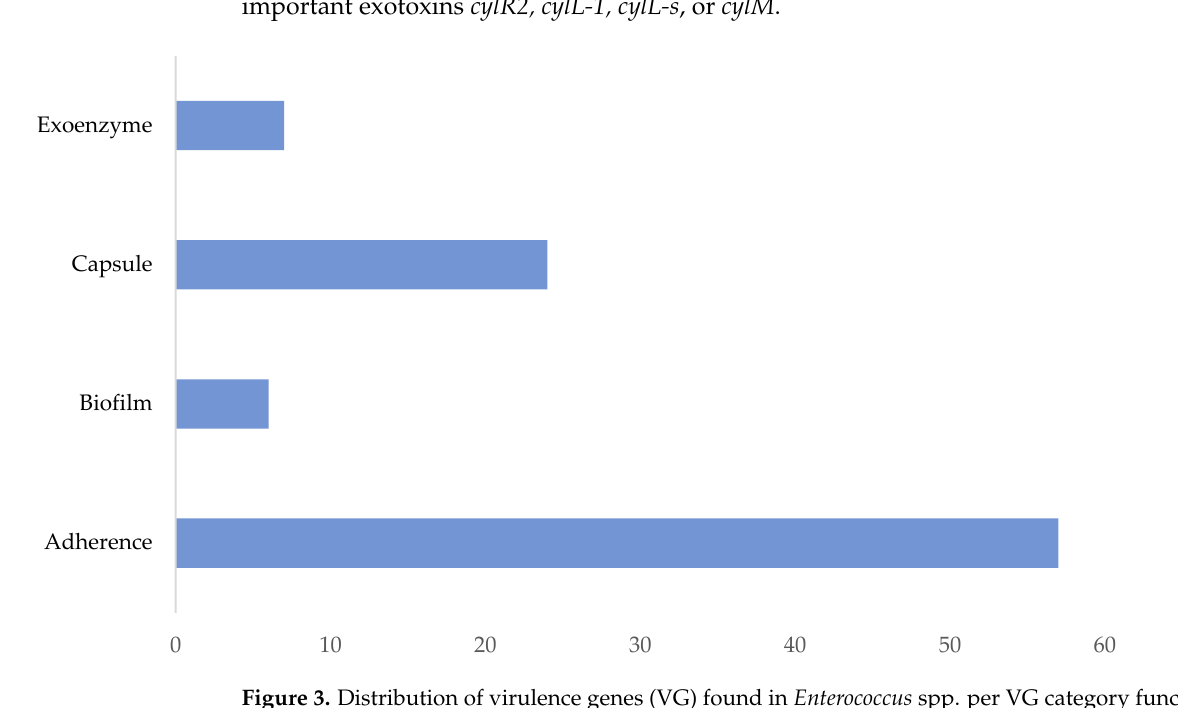
Figure 3. Distribution of virulence genes (VG) found in Enterococcus spp. per VG category function.